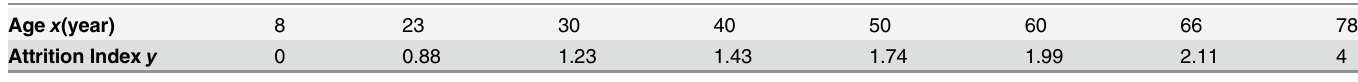
Table 2. Average Attrition Index of lower molar at Different Ages.